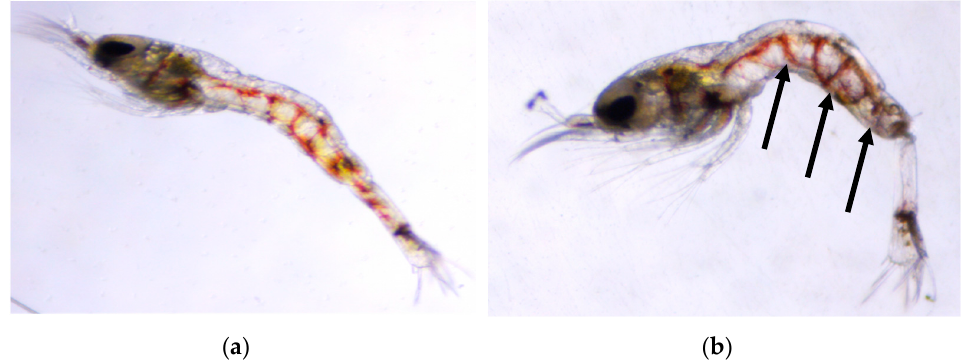
Figure 5. A. lanipes larvae exposed to TiO 2 NPs for 72 h showed edema development: ( a ) control A. lanipes larva; ( b ) A. lanipes larva exposed to 150 mg/L of TiO 2 NPs. The images were obtained using a stereo microscope (3.5 × -90 × LED Trinocular Zoom + 14 MP USB 3.0 Digital Camera). Both larvae were in the zoea I larval stage; the total length of the larvae is 1.3 mm. No significant differences in total length among the control and exposed groups were observed (Figure 6). Nevertheless, we found that, at 72 h of exposure, two concentrations (50.0 and 100.0 mg/L) of TiO 2 NPs showed statistical significance compared to the control group means. The one-way ANOVA analysis showed total length: F (5,144) = 3.907; p < 0.01. Consequently, the Tukey test showed similarities between the 50.0 and 100.0 mg/L of TiO 2 NPs ( p < 0.05).